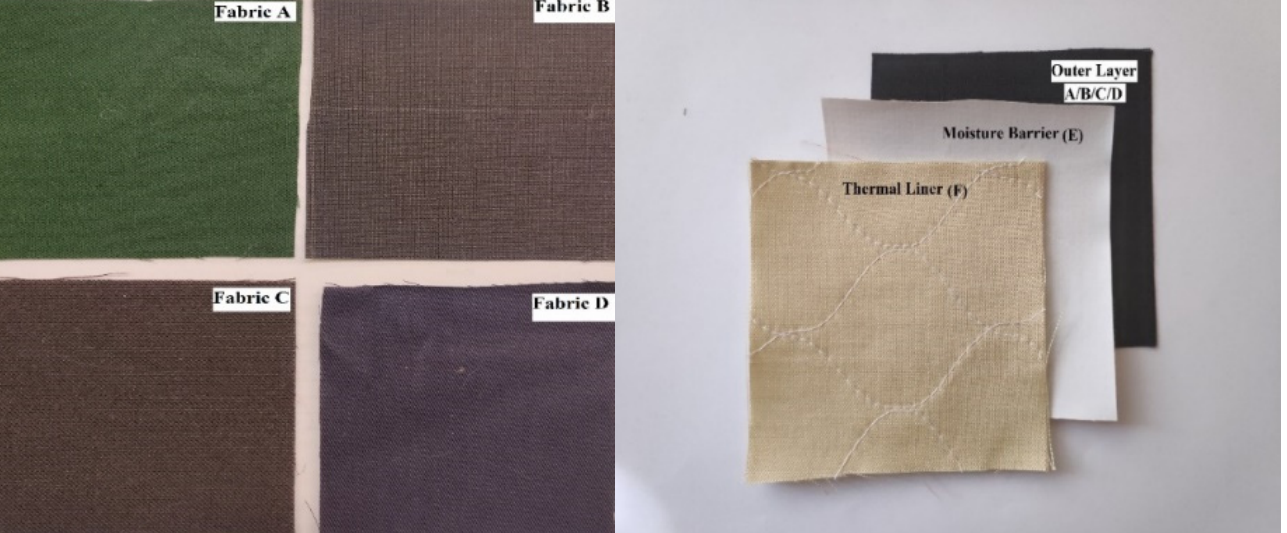
Figure 1. Fabric A, B, C, D, and an arrangement of a three-layered fabric system. The properties of all four high-performance fabrics are listed in Table 1. Table 1. Properties of the high-performance fabrics experimented.